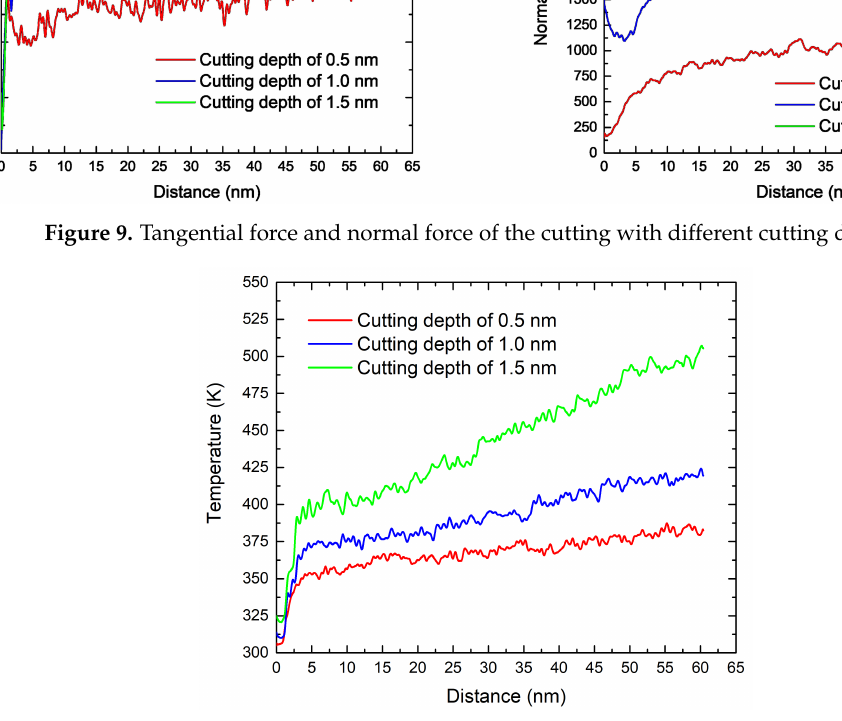
Figure 10. Workpiece temperature of the cutting with different cutting